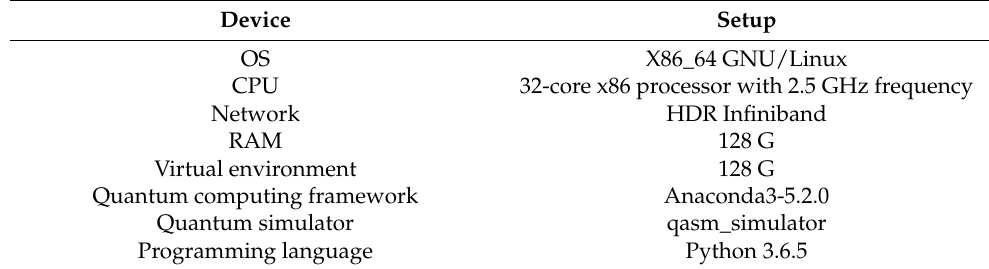
Table 1. Computing Table 1. Computing environment.